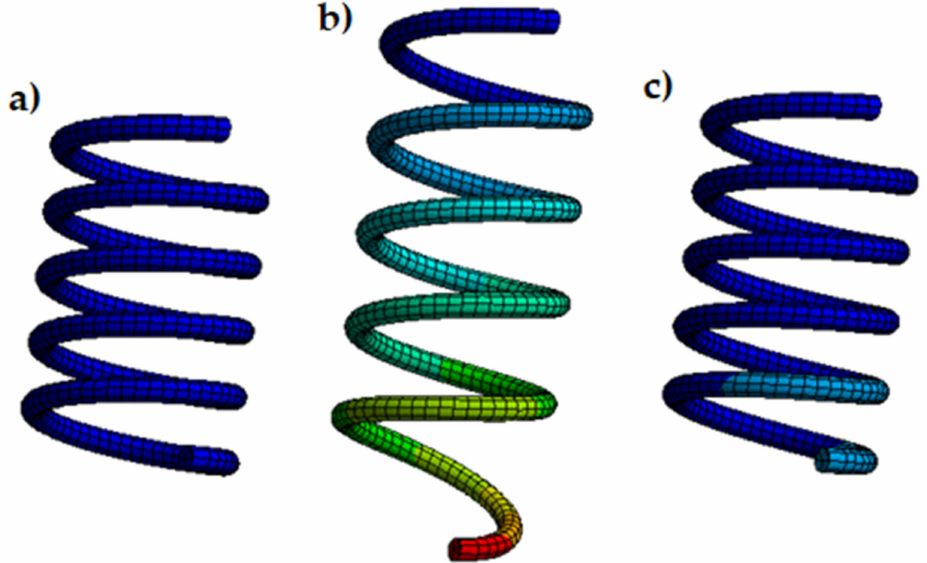
Figure 7. Deformed shape compared with undeformed shape. ( a ) spring at the initial step 0, ( b ) deformed spring after step 1, ( c ) the spring recovers its shape after the heating process. The scheme used to control the Mosfet is that of Figure 8. The simulations have been carried out with